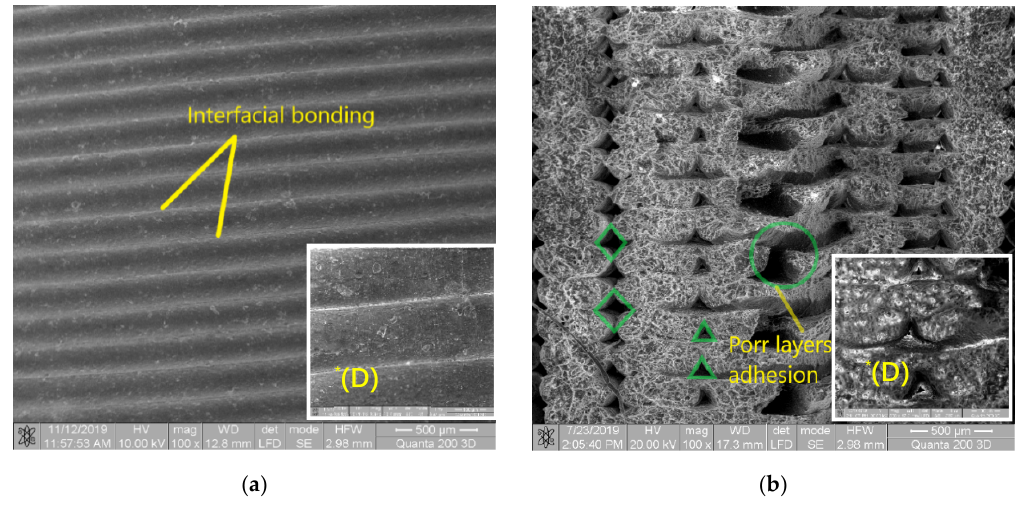
Figure 10. SEM images of the sample prototyped from Extrudr BDP Flax. ( a ) SEM image on the sample surface. ( b ) SEM image in the breaking area. *(D) detail, 500×.